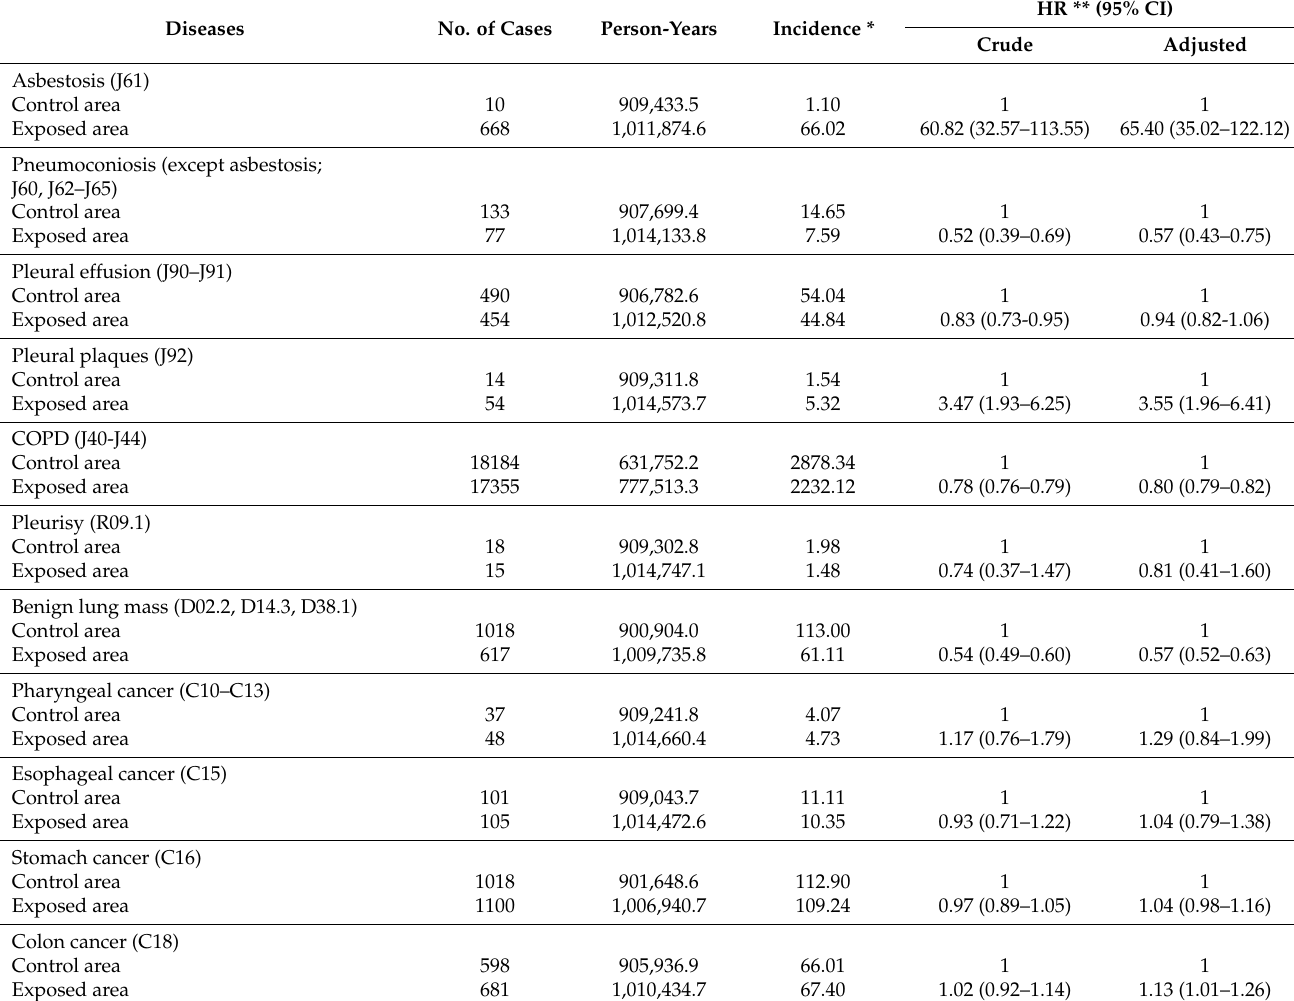
Table 2. Incidence rates and hazard ratios of asbestos-related diseases in the exposed and control areas. Diseases No. of